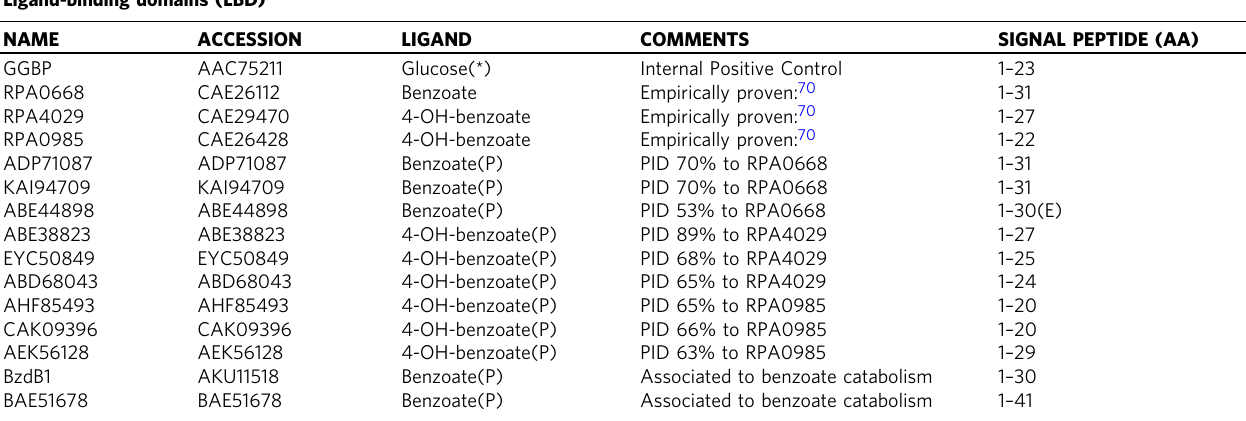
Table 2 Ligand-binding domains included in the chimeric TFs Ligand-binding domains